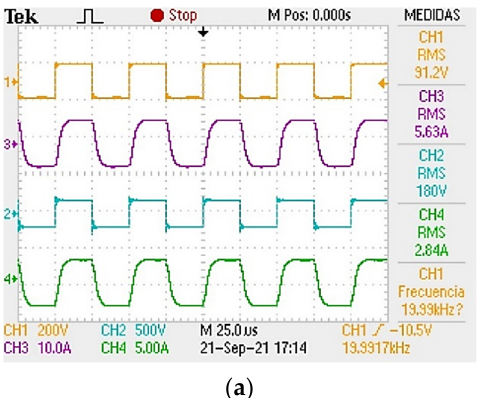
Figure 13. MFT input and output voltages and currents (25% P nom ): ( a ) Nanocrystalline, ( b ) Ferrite.